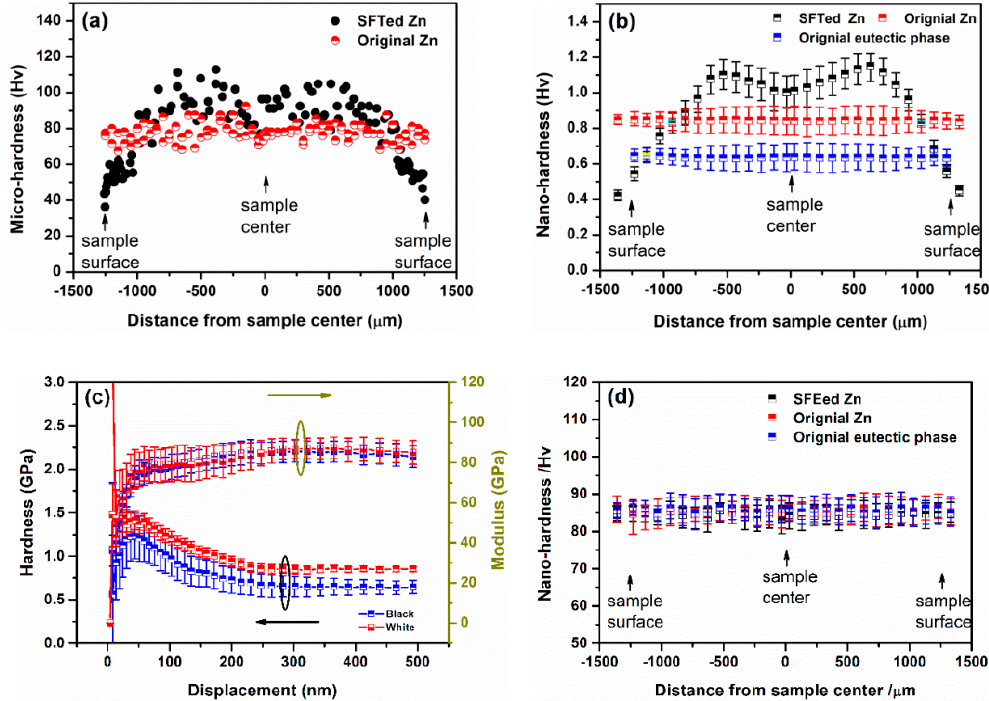
Figure 5. ( a ) Micro- and ( b ) nano-hardness distribution of the cross sectional in the Zn alloy before and after SFT-treatment; ( c ) continuous E and H of original Zn and eutectic phase at depth of 500 nm using CSM mode. The corresponding E values ( d ) in the ( b ).